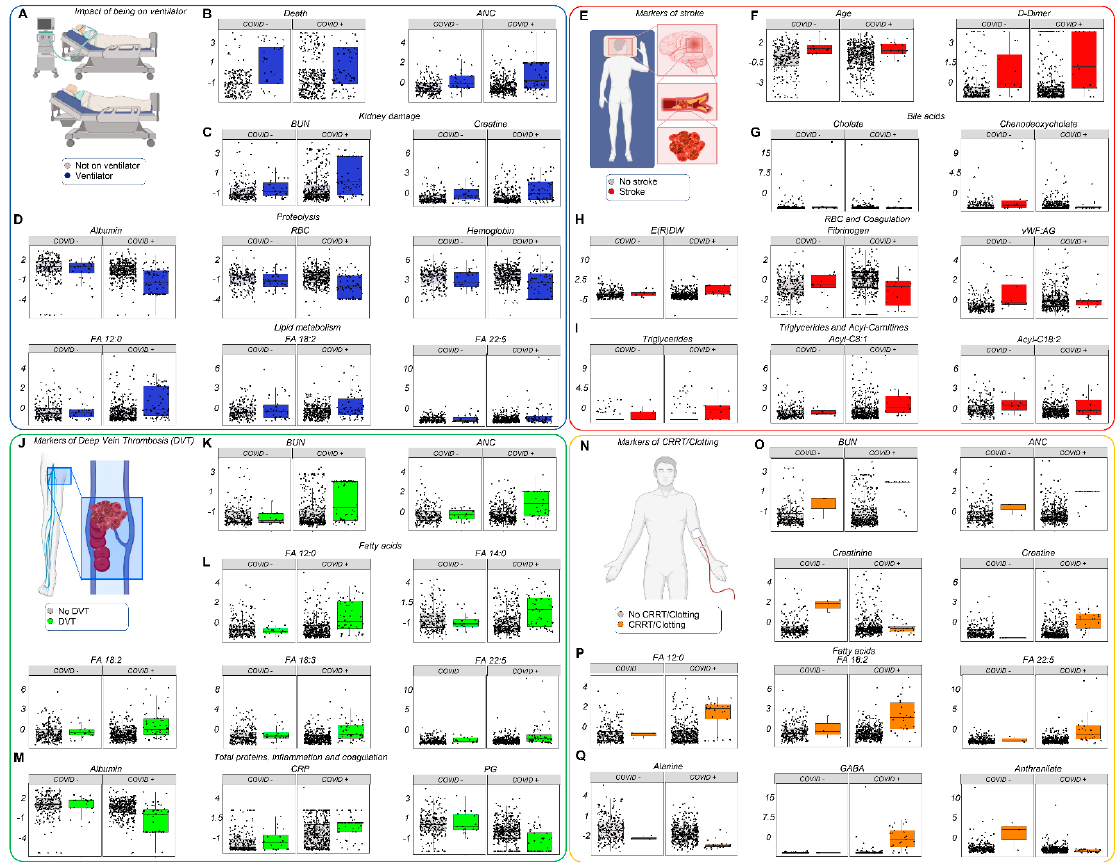
Figure 6. Clinical complications and metabolic/clinical markers. Hospitalized patients, with and without COVID-19,